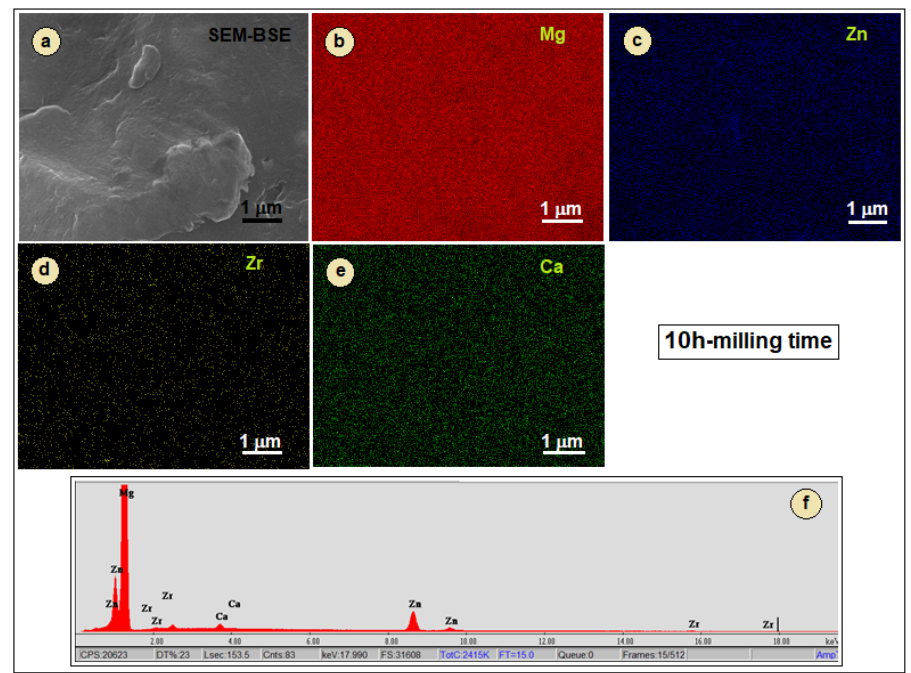
Figure 10. Distribution map of alloying elements for the powder-alloy processed by mechanical alloying at 10 h/300 rpm: ( a ) SEM image of the powder; ( b ) SEM-EDS distribution of Mg; ( c ) SEM- EDS distribution of Zn; ( d ) SEM-EDS distribution of Zr; ( e ) SEM-EDS distribution of Ca; ( f ) global EDS